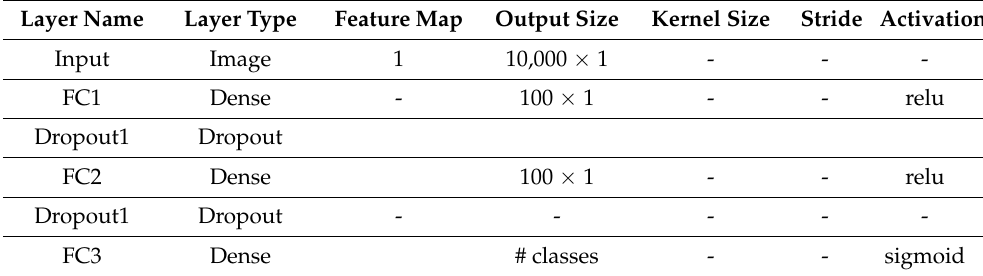
Table 2. Specifications of second